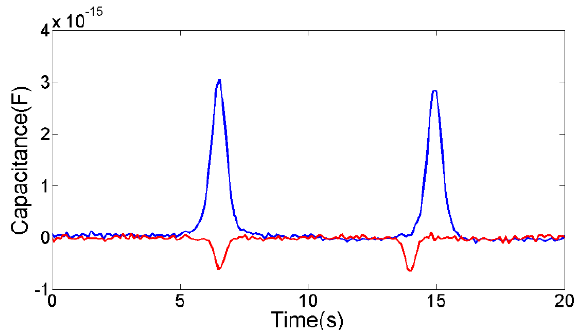
Figure 9. The capacitance detection results, the red line is the signal of 253 μm air bubble, the blue line is the signal of 245 μm water droplet.